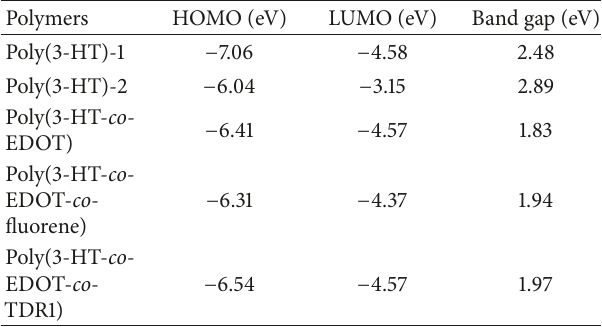
Table 4: Energy levels of the